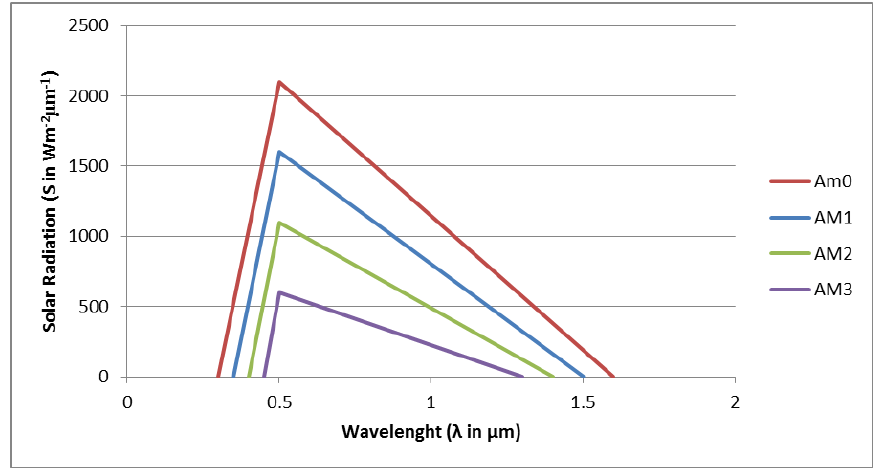
Figure 2. Schematic diagram of the spectral distribution of solar radiation